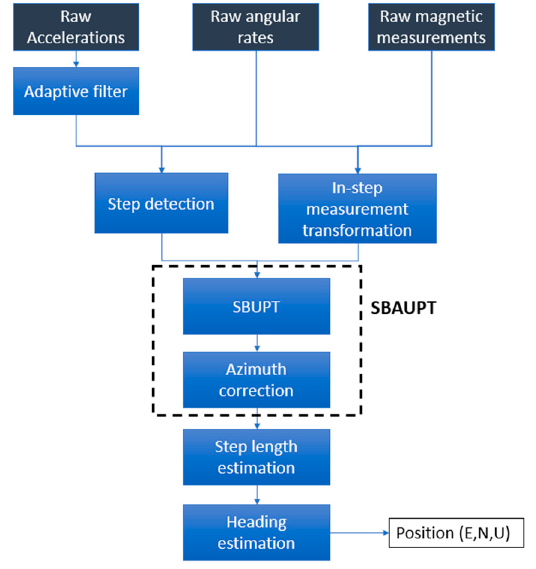
Figure 4. S-PDR flowchart.